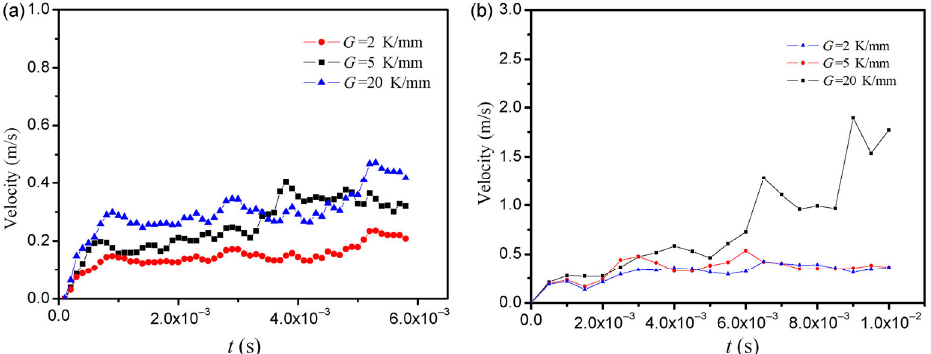
Fig. 11 (a) Thermocapillary migration velocities of molten silicon on (a) corundum ( θ = 90°) and (b) graphite ( θ = 45°) substrates under different G